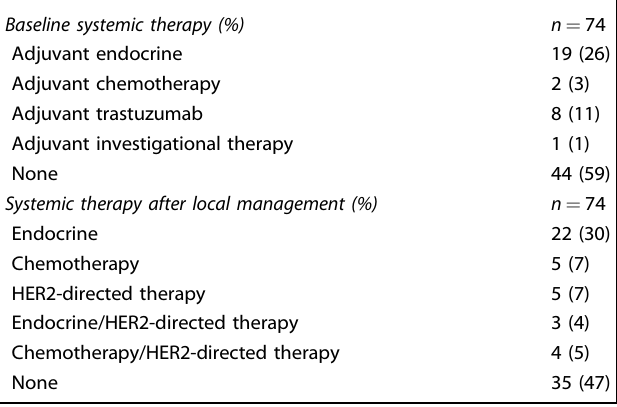
Table 2. Systemic management for analyzed patients.